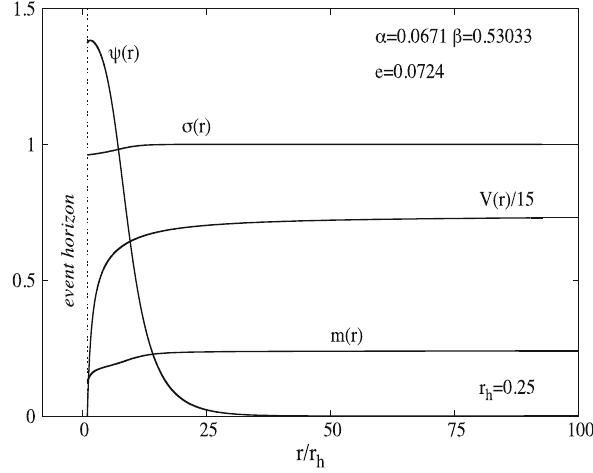
Fig. 2 Profile functions of an illustrative BH with gauged scalar hair, as functions of the radial coordinate